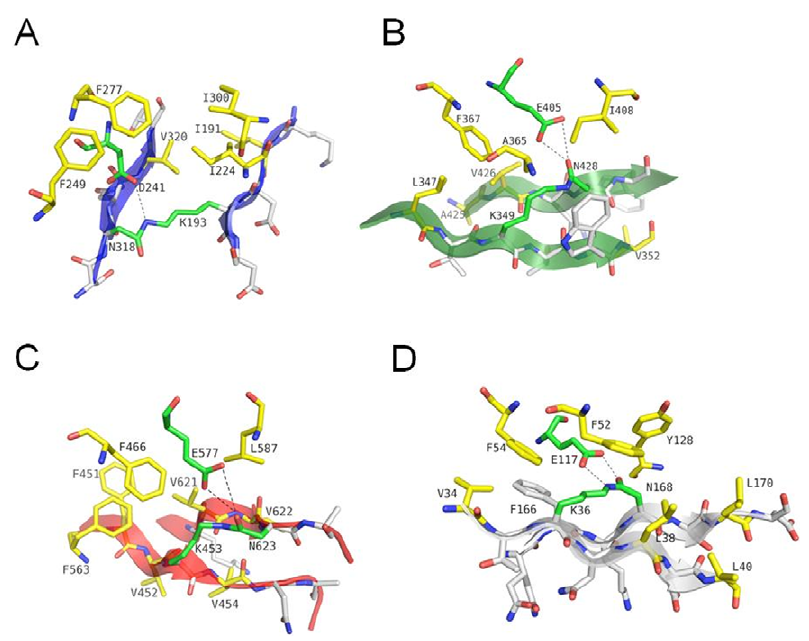
Figure 4. Isopeptide Bonds of RrgB and Spy0128. A) and B) the isopeptide bond between residues Lys193 and Asn318 in domain 2 (D2) of RrgB. Dashed lines show the distance of the carboxylate anion provided by Asp241; the isopeptide bond between Lys 349 and Asn428 in domain 3 (D3) and the position of Glu405 contributing the carboxylate anion; the isopeptide bond between Lys 453 and Asn623 and the position of Glu577 in domain 4 (D4). C) Sigma-a weighted 2Fo – Fc map contoured at 1 s level is shown for the isopeptide bond in D4 of RrgB. D) Isopeptide bond between Lys36 and Asn168 in Spy0128 (drawn from PDB 3b2m). Carbon atoms are coloured green for residues involved in the formation of the isopeptide bonds, yellow for neighbouring hydrophobic residues, and gray for residues adjacent to the isopeptide bond. Oxygen and nitrogen atoms are coloured red and blue, respectively. Figure produced by Pymol.